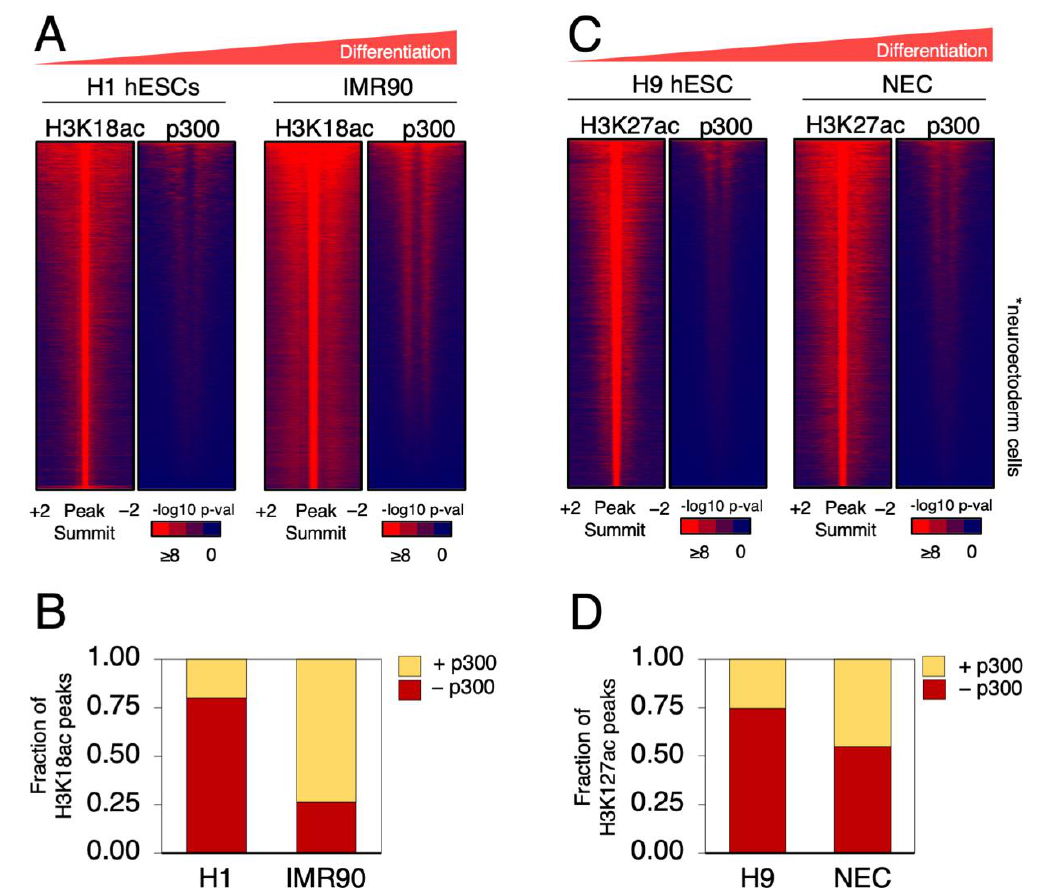
Figure 1. p300 is more associated with H3 acetylated regions in differentiated cells than in H1 and H9 hESCs. ( A ) Heatmap of H1 hESCs H3K18ac and IMR90 H3K18ac sites independently ranked from high to low acetylation. For the same regions of acetylation, the heatmaps of associated levels of p300 in each cell line are also shown. The increase in differentiation is indicated by the red triangle above the figure. Color bar scale with increasing shades of color stands for higher enrichment ( − log10 of the Poisson p -value). ( B ) Fraction of H3K18ac peaks occupied (+) or not ( − ) by p300 for the indicated cell lines represented in ( A ). ( C ) Heatmap of H3K27ac peaks in H9 hESCs and NECs shown as in ( A ). The increase in differentiation is indicated by the red triangle above the figure. Color bar scale with increasing shades of color stands for higher enrichment ( − log10 of the Poisson p -value). ( D ) Fraction of H3K27ac peaks occupied (+) or not ( − ) by p300 for the indicated cell lines represented in ( C ).